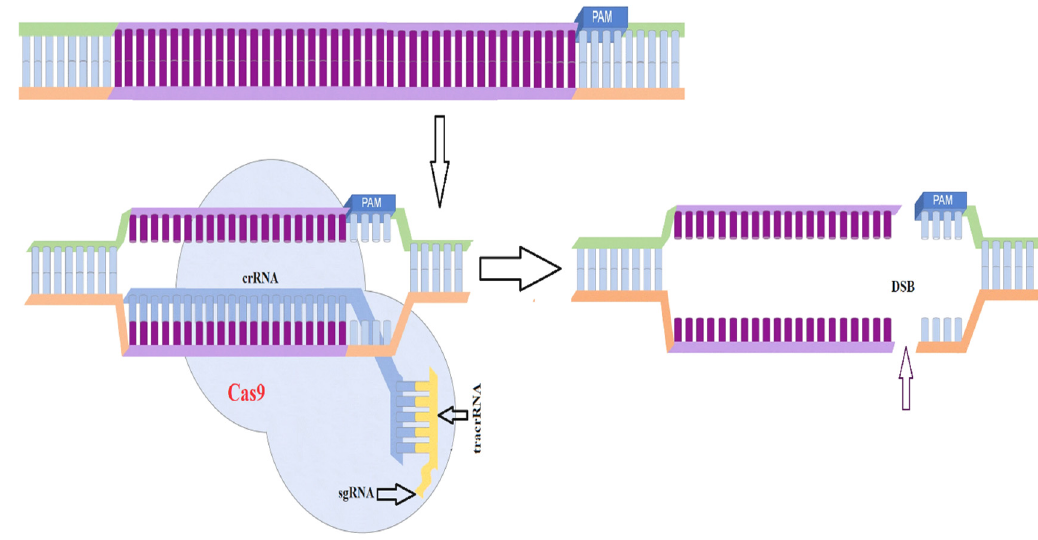
Figure 4. Cas9 induced double-strand break in a target gene. The sgRNA comprises tracrRNA and crRNA. The crRNA is specific to the target DNA, and the Cas9 enzyme creates a double strand break upstream of the PAM motif [28].